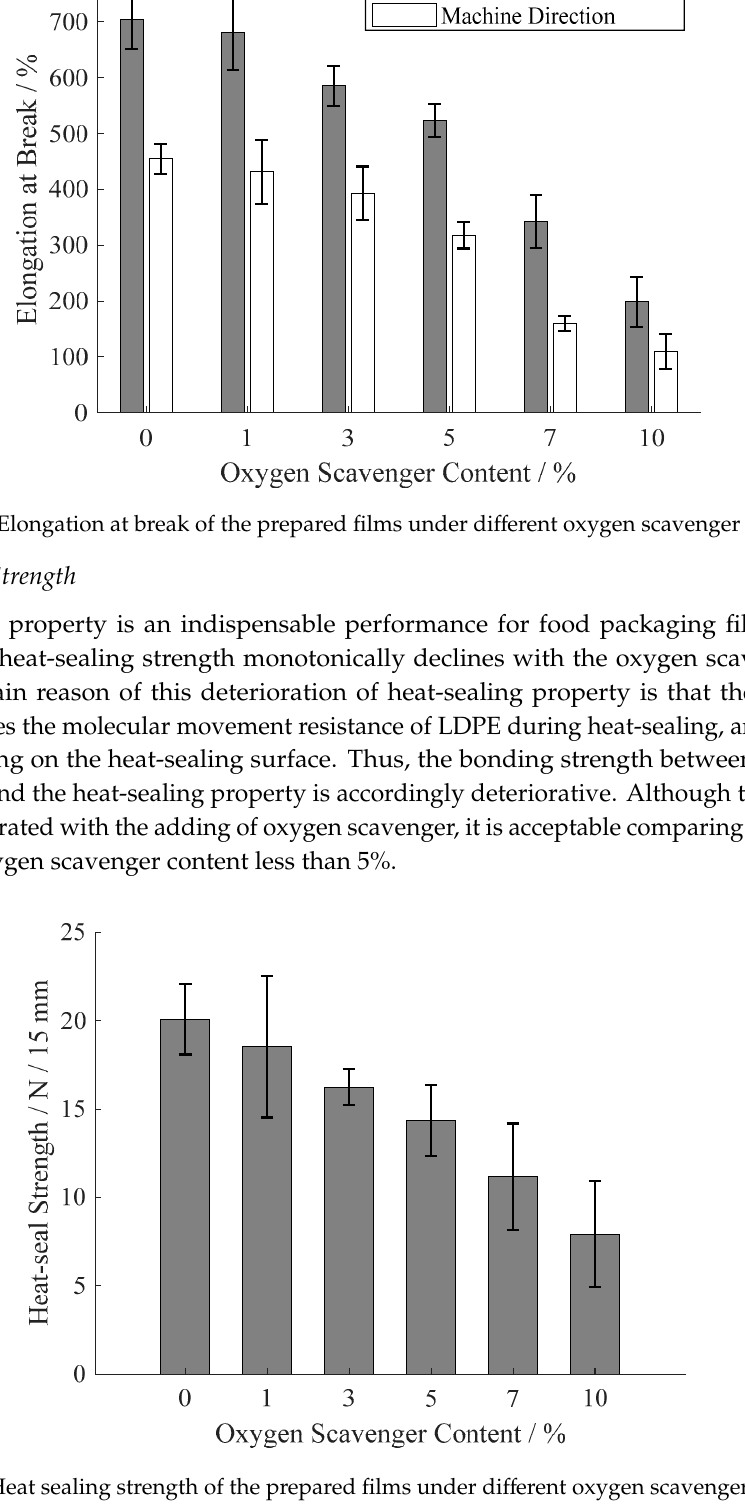
Figure 9. Tensile strength of the prepared films under different oxygen scavenger content.